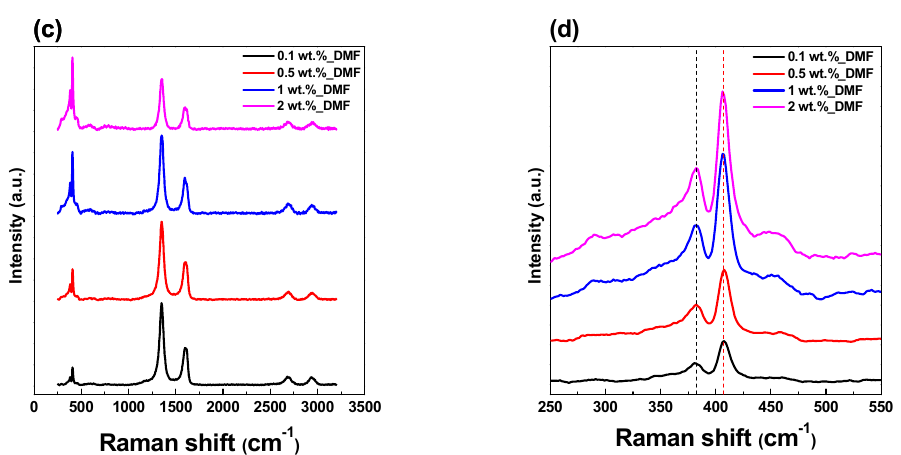
Figure 2. Raman shifts of the hydrogen radical-treated MoS 2 –CNW samples depending on the or- ganic solvent type and ATTM concentration: ( a ) MoS 2 –CNW synthesis using acetonitrile, depending on the ATTM concentration; ( b ) enlarged spectra of the E 1 2 g and A 2g modes in ( a ); ( c ) MoS 2 –CNW synthesis using dimethylformamide (DMF), depending on the ATTM concentration; and ( d ) enlarged spectra of the E 1 2 g and A 2g modes in ( c ).